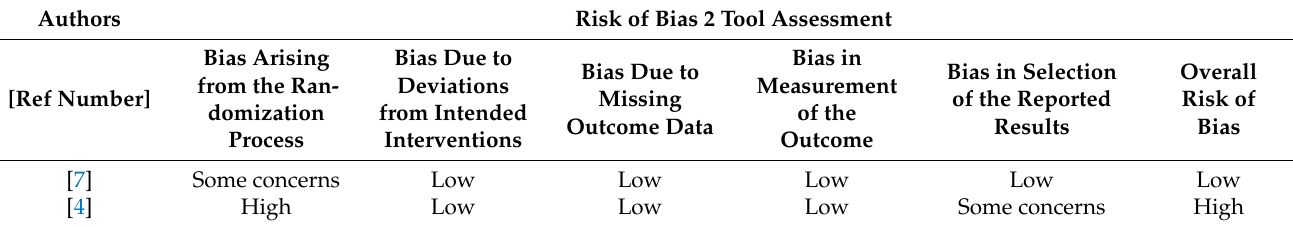
Table 2. Quality scores for the eligibility studies for recurrence rate.